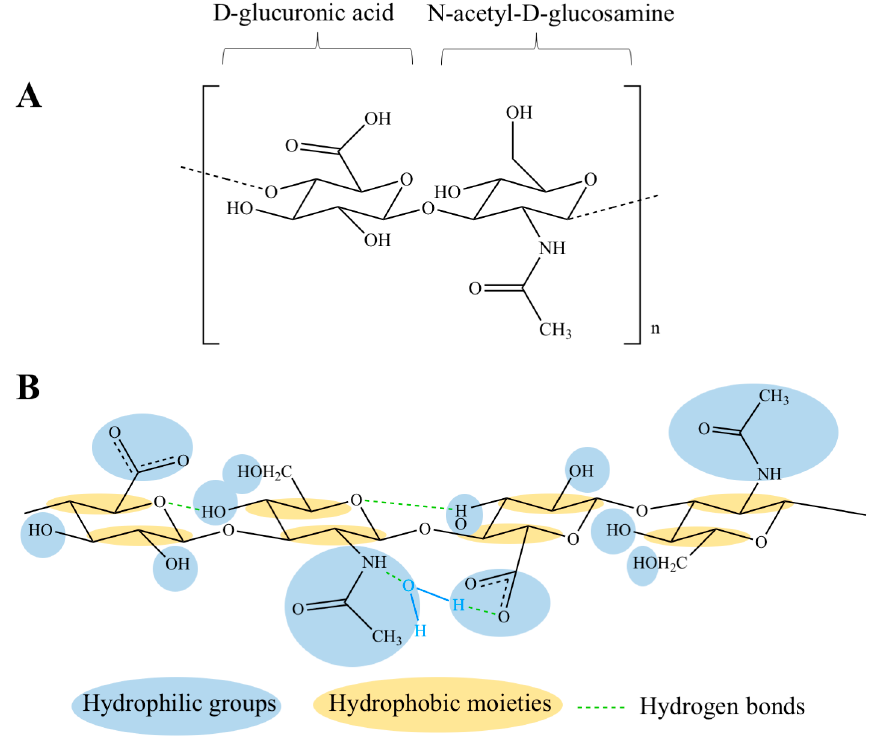
Figure 1. Chemical structures of HA disaccharide unit ( A ) and HA tetrasaccharide unit where the hydrophilic functional groups and the hydrophobic moieties are respectively evidenced in blue and yellow, while the hydrogen bonds are represented by green dashed lines ( B ).